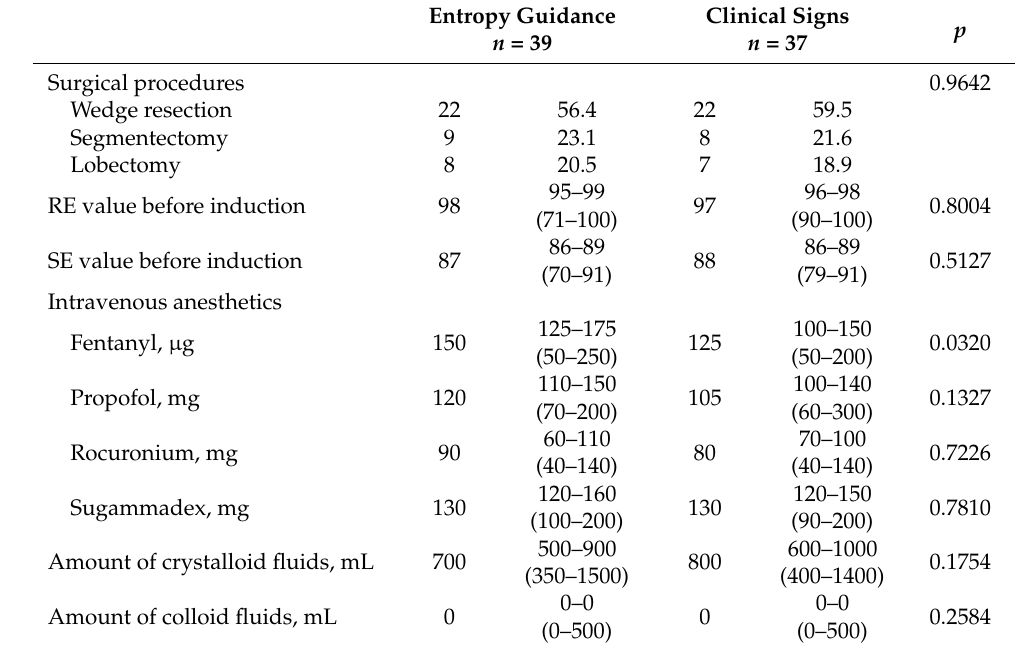
Table 2. Surgical and anesthetic